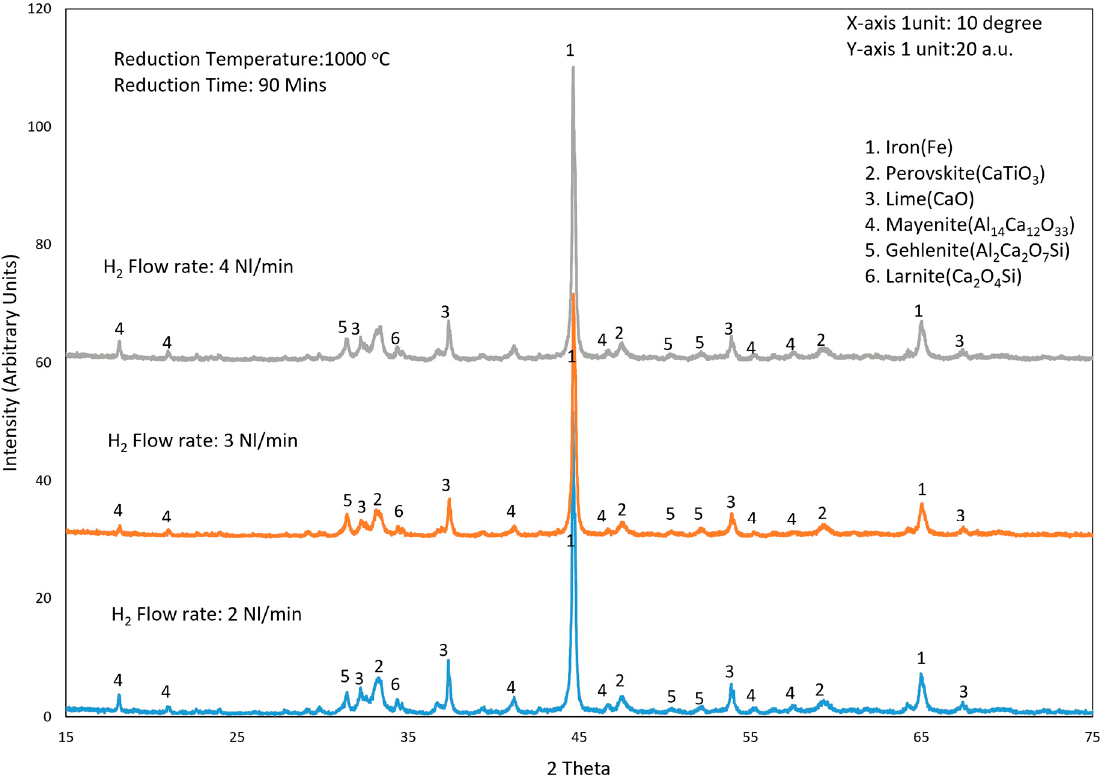
Figure 9. X-ray diffraction analysis of samples reduced at different flow rates of hydrogen with constant reduction time and temperature.